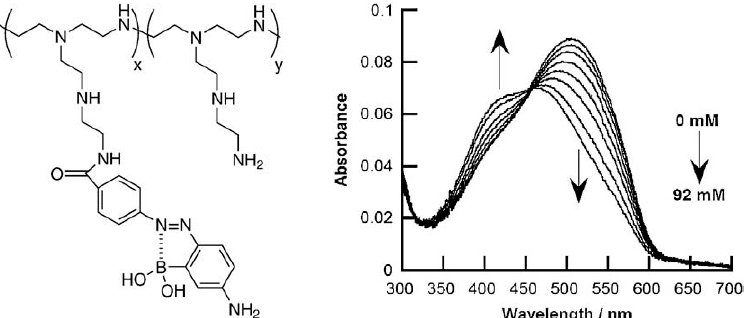
Figure 8. ( left ) Chemical structure of PEI modified with boronic acid-substituted azobenzene dye; ( right ) Absorption spectra of the azobenzene-modified PEI in the absence and presence of glucose. Reprinted with permission from Ref. [80]. Copyright 2009 from Elsevier.